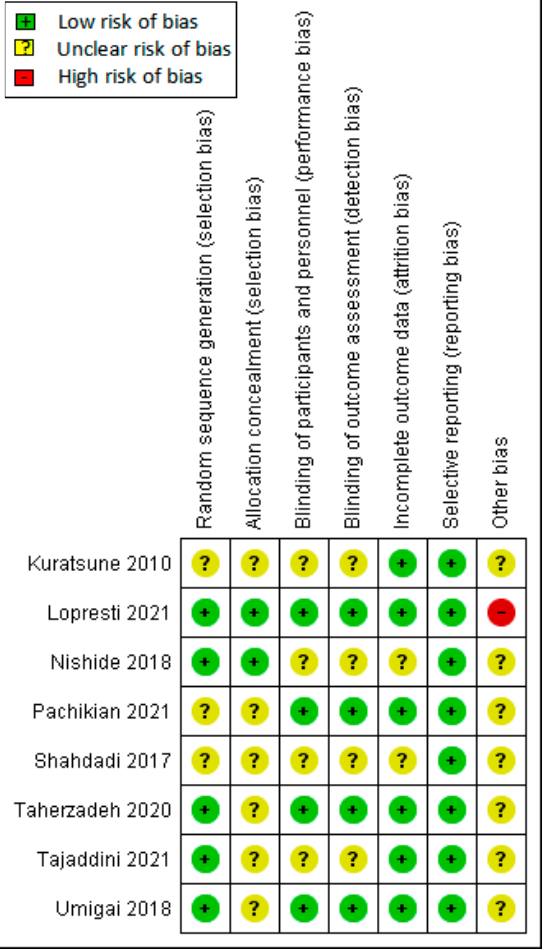
Figure 3. Judgements about each risk of bias item for each included study [24–31].